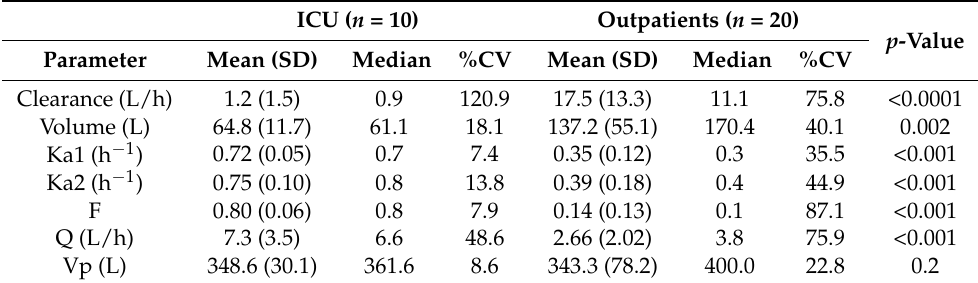
Table 3. Estimates of ethambutol pharmacokinetic parameters for the final covariate model.